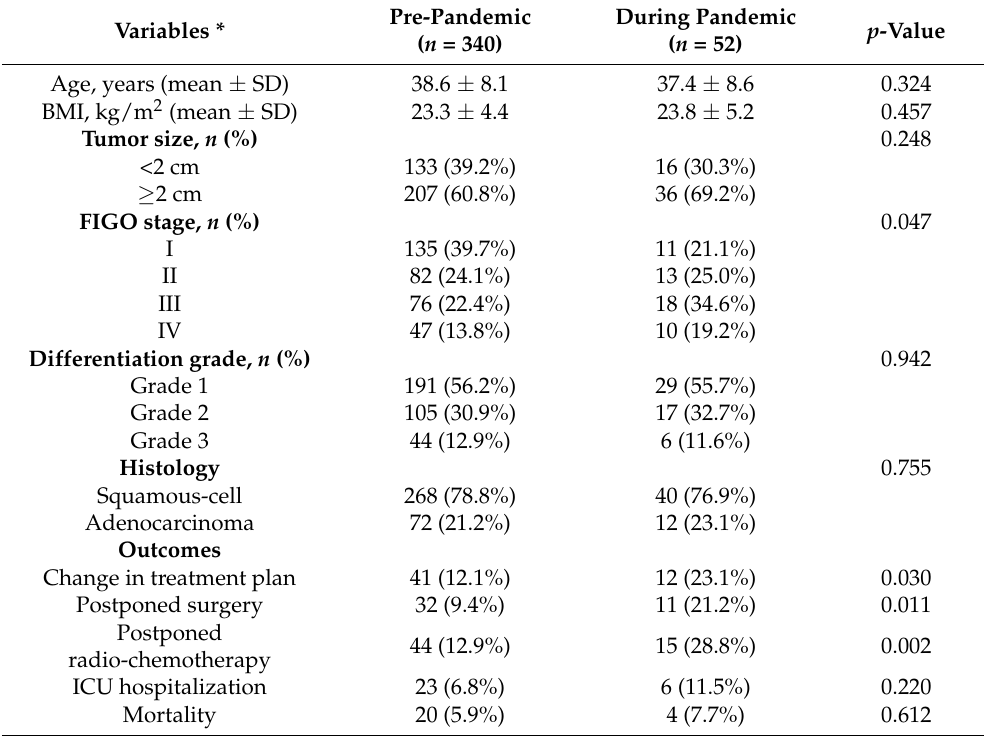
Table 1. Characteristics of new patients with cervical cancer presenting at gynecology and general surgery clinics for investigations and treatment over a course of six years before and during the COVID-19